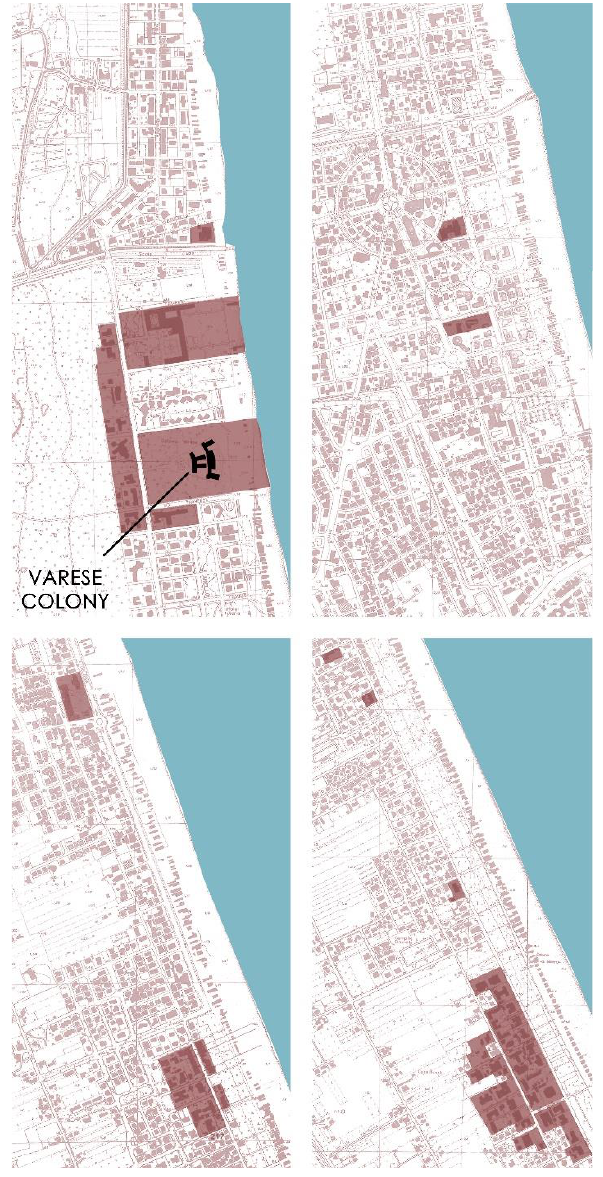
Figure 2 . Highlighting of colonies in Cervia area.